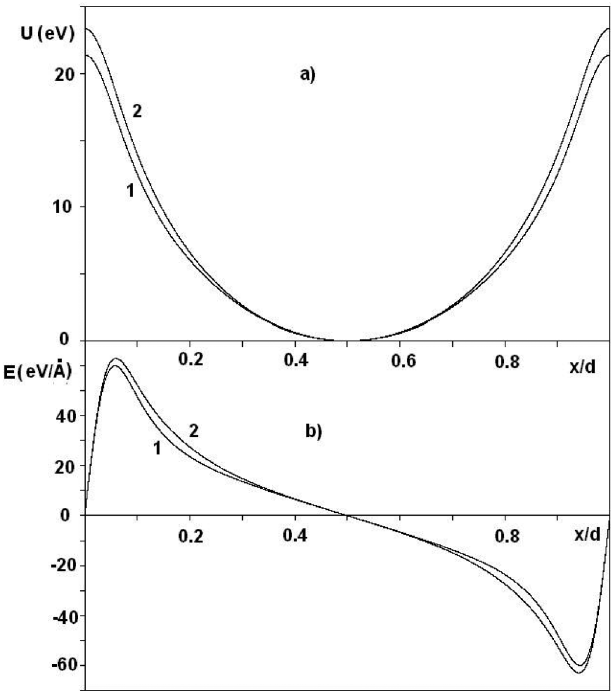
FIG. 2. One-dimensional potential (a) and electric field (b) in the (110) plane of a silicon single crystal (at the room tempera- ture), as functions of the relative coordinate x=d , where d (cid:5) 1 : 92 (cid:2)A is the interplanar distance. Curves 1 and 2 correspond to calculations based on the atomic form factors from x-ray mea- surements and the Moliere model.